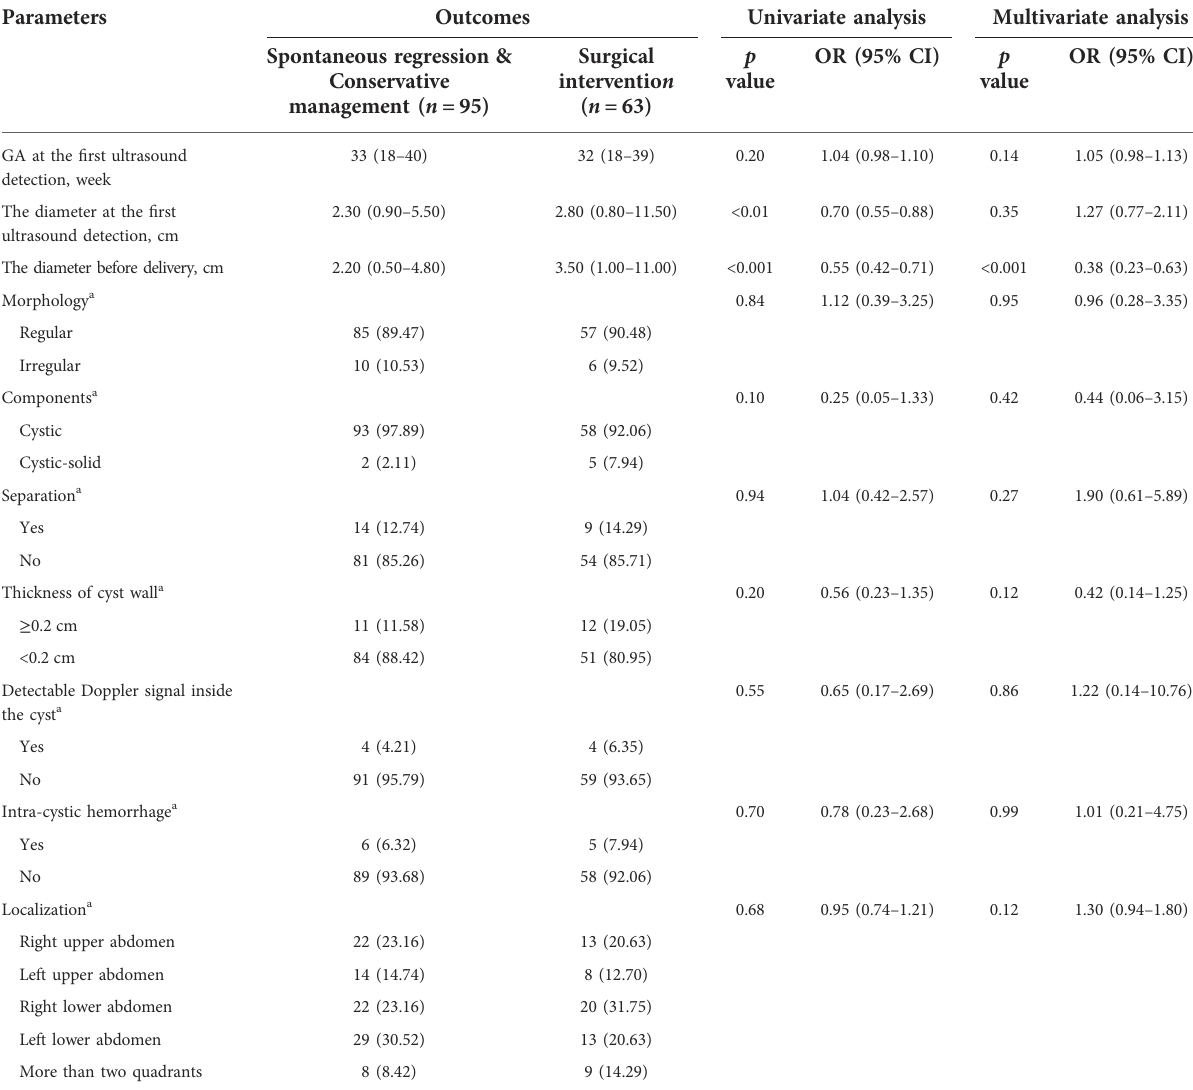
TABLE 4 Univariate analysis and multivariate analysis of possible predictors of surgical intervention postnatally in 158 fetuses with intra-abdominal cysts.